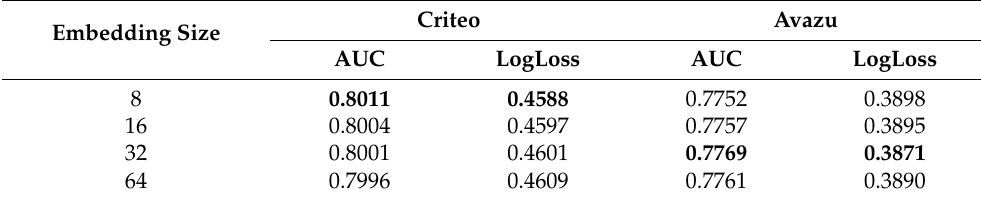
Table 3. Performance comparison of different